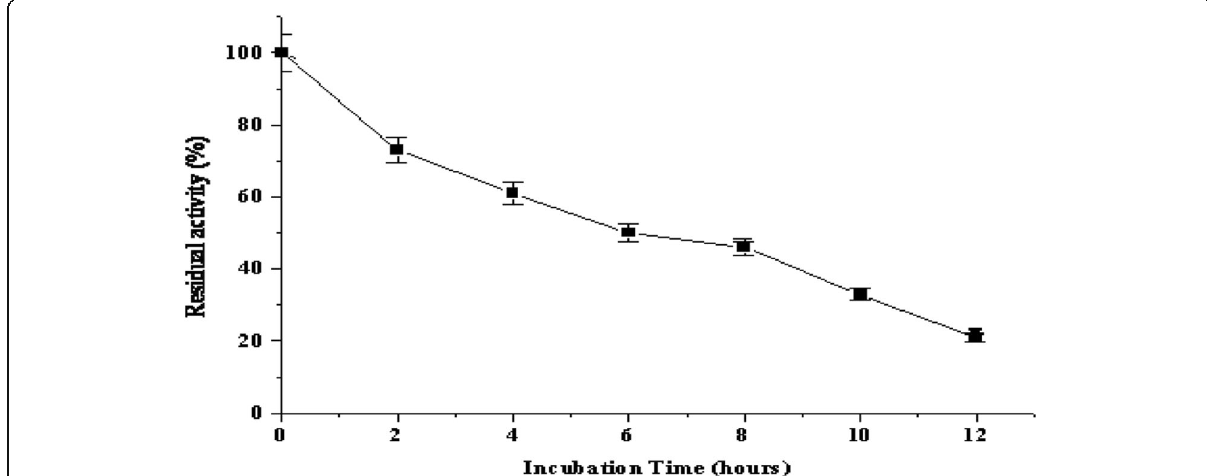
Fig. 6 Thermo stability of alpha-galactosidase from Penicillium sp.